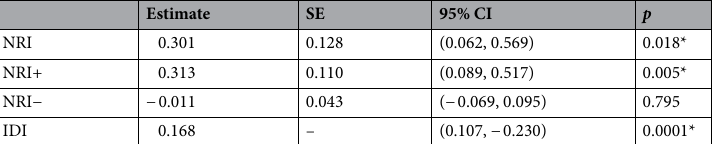
Table 3. The predictive efficiency of AIDD and AIDo was evaluated by NRI and IDI in training set. * p < 0.05 for significance. NRI net reclassification index, IDI integrated discrimination index, CI confidence interval, SE standard